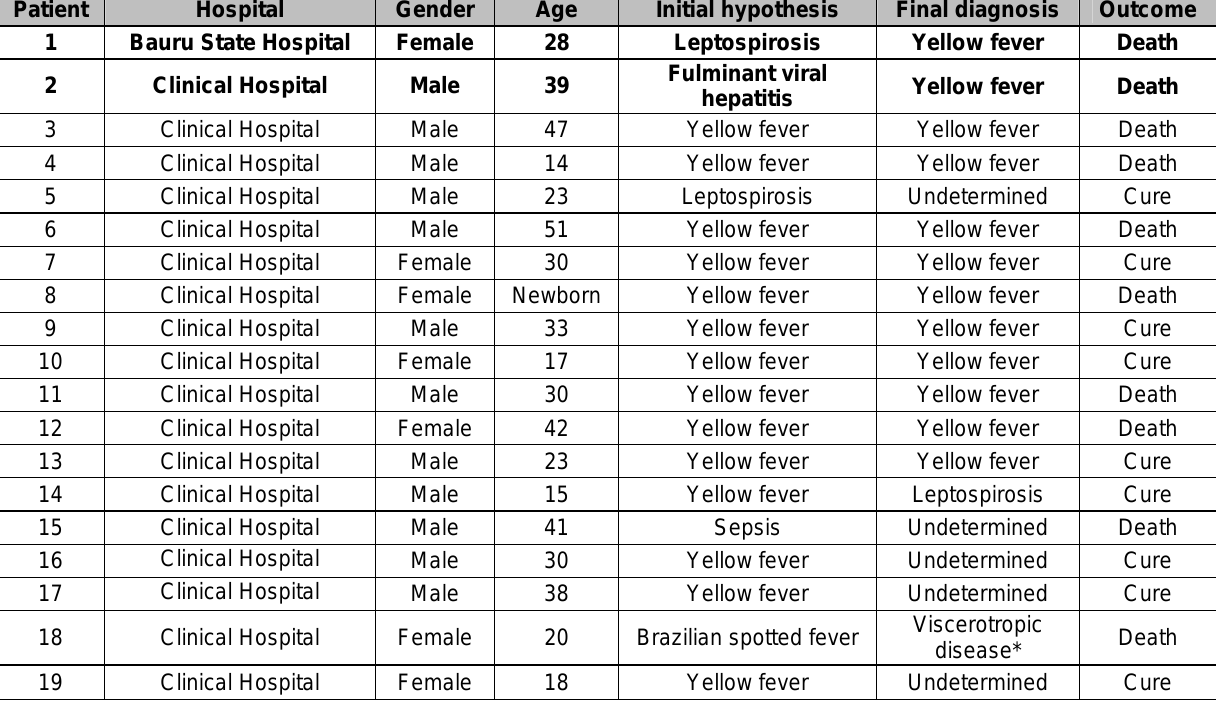
Table 1. List of patients admitted to the teaching hospitals of Botucatu Medical School with acute febrile ictero-hemorrhagic syndrome (AFIHS), from February to April, 2009. The first two cases identified by syndromic surveillance are printed in